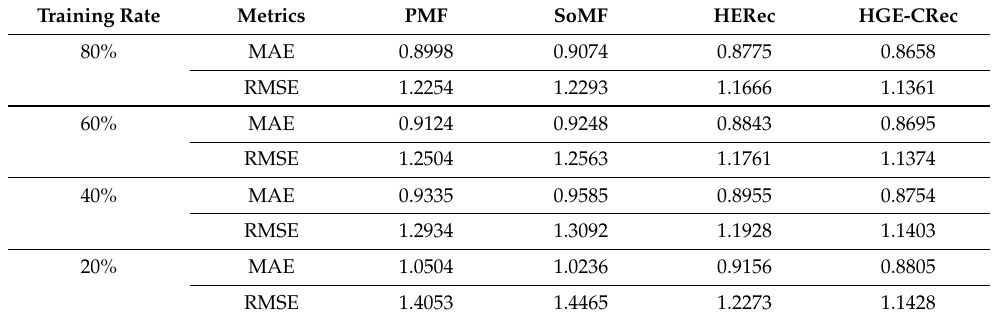
Table 5. Results on CNPC.